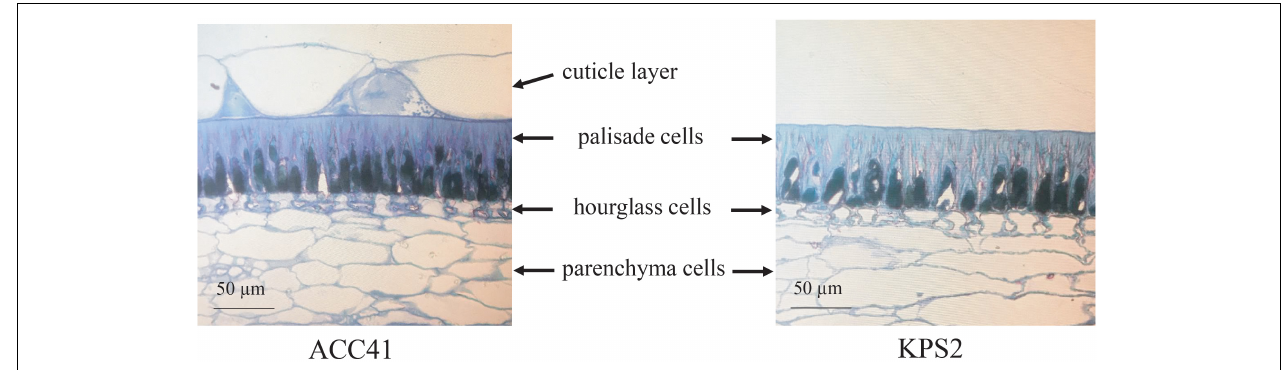
FIGURE 2 | Transverse sections of the seed coat at the maturation stage of the cultivated mungbean of wild mungbean ACC41 and cultivated mungbean KPS2, stained with 0.05% toluidine blue O.